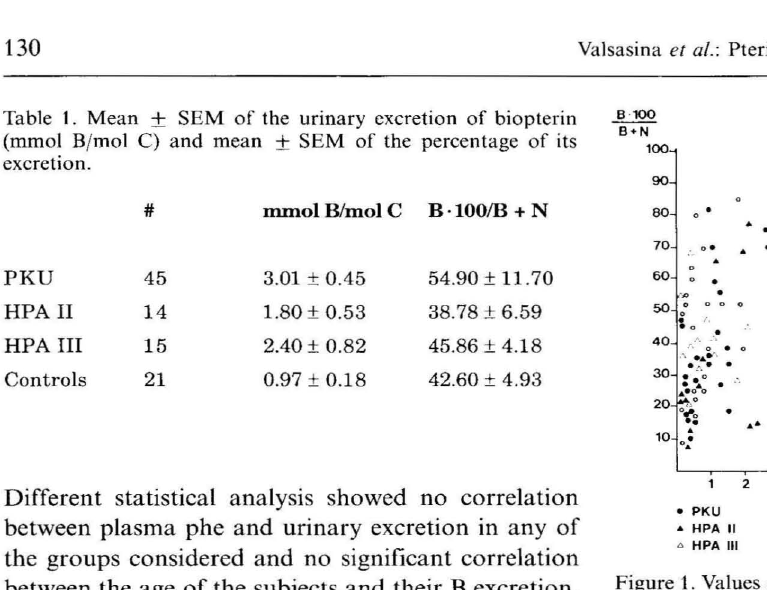
Figure 1. Values of the excretion of biopterin and its percentage of excretion in the patients affected by PKU, HPA II, HPA III. and in healthy controls, plotted on a system of cartesian